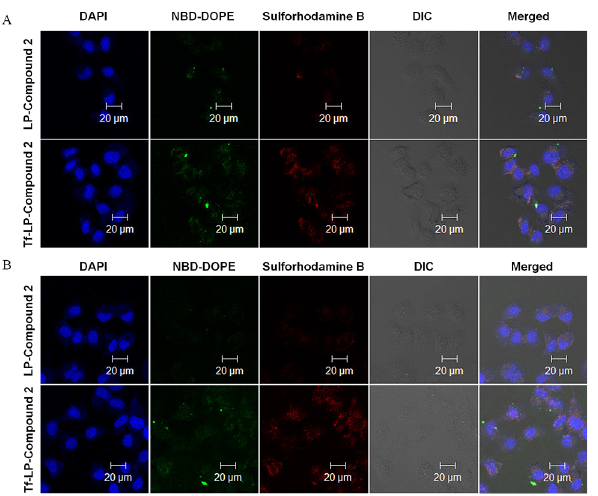
S1 Table. The Coupling efficiency of Tf. Data are shown as means and standard